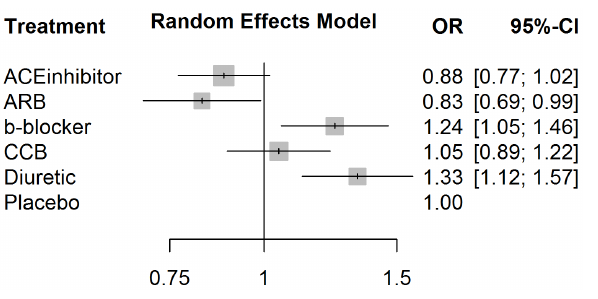
Fig. 3. A forest plot of the estimates of odds ratios between each treatment and the reference placebo created using the gemtc R package and diabetes